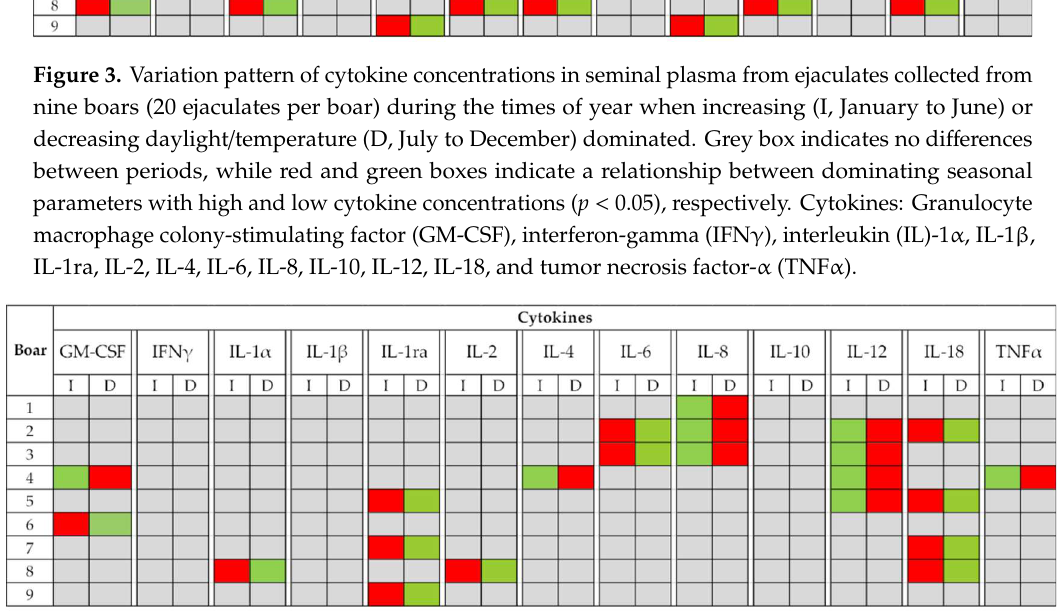
Figure 4. Variation pattern in the total amount of seminal plasma cytokines in ejaculates collected from nine boars (20 ejaculates per boar) during the periods of increasing (I, January to June) or decreasing daylight/temperature (D, July to December). Grey box indicates no differences between periods, while red and green boxes indicate a relationship between dominating seasonal parameters with high and low total cytokine amounts (p < 0.05), respectively. Cytokines: Granulocyte macrophage colony-stimulating factor (GM-CSF), interferon-gamma (IFNγ), interleukin (IL)-1α, IL- 1β, IL-1ra, IL-2, IL-4, IL-6, IL-8, IL-10, IL-12, IL-18, and tumor necrosis factor-α (TNFα).